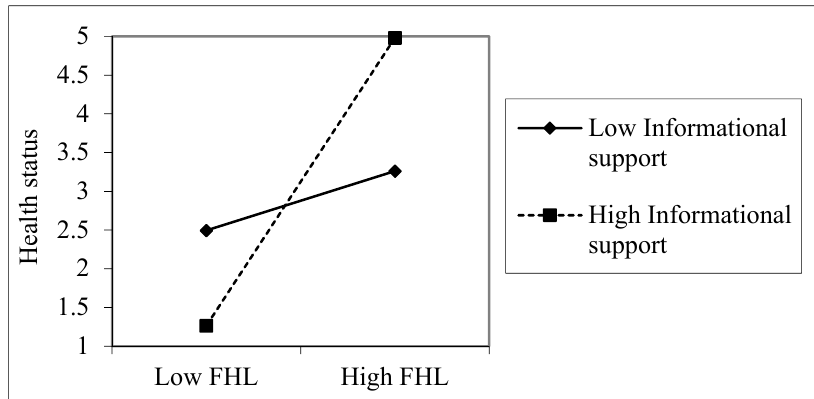
Figure 3. The association between informational support, FHL, and health status, the overall sample. Health status was measured on a five-point scale (poor, fair, good, very good, and excellent). The values used in the plotting are based on the unstandardized regression coefficients.